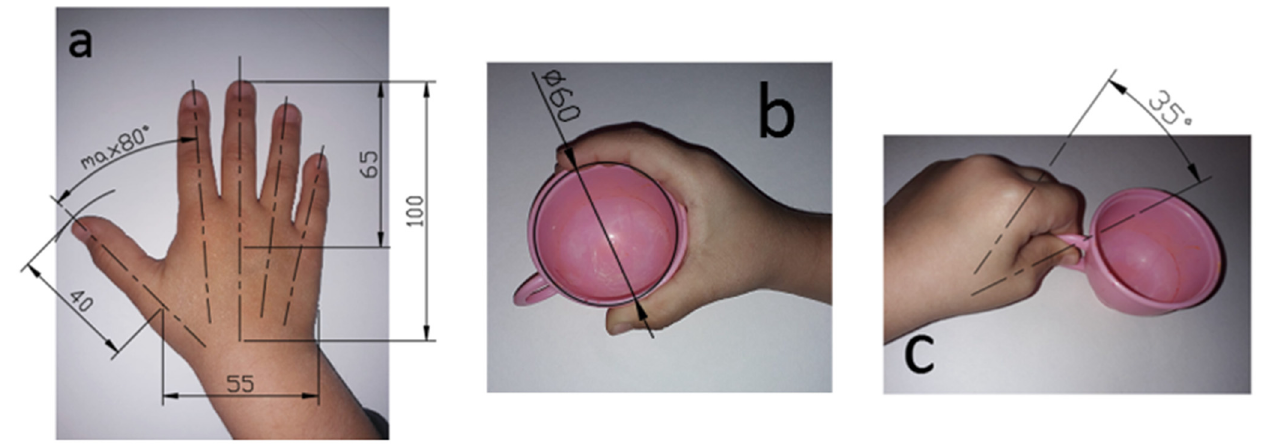
Figure 3. ( a ) Degrees of mobility, ( b ) full-hand grip position, ( c ) finger grip